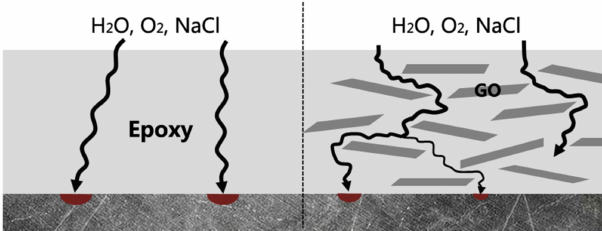
Figure 9. Schematic representation of corrosion protection mechanism of GO-epoxy coatings.